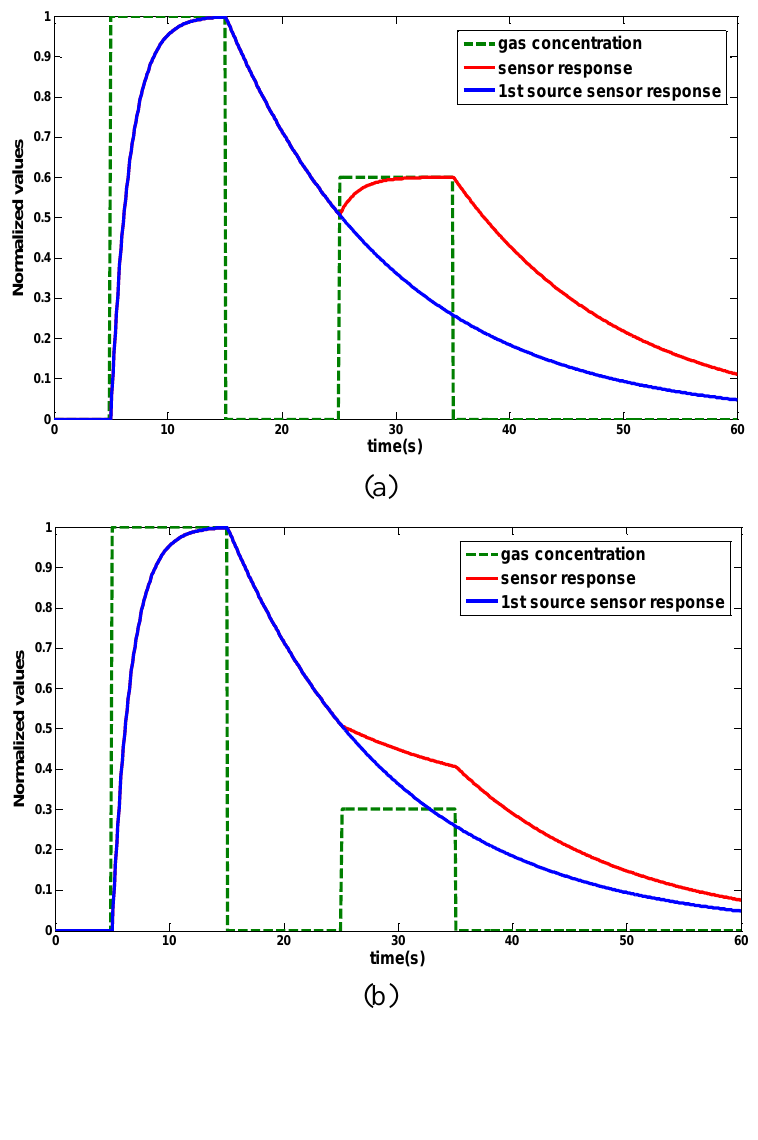
Figure 2. Simulations of the behavior of a MOS sensor when sensing a low gas concentration right after being exposed to a stronger one. The MOS sensor response has been modeled as a two-phase first-order system with time constants 1.7 s, and 14.8 s, for the rise and decay stages respectively (estimated from system identification techniques). Three different scenarios have been simulated varying the source strength ration between both sources: (a) 80%, (b) 30% and (c) 10%. Observe that, when the second gas source is much lower than the first, the response of the MOS sensor (in red) is very similar to that obtained from the first source alone